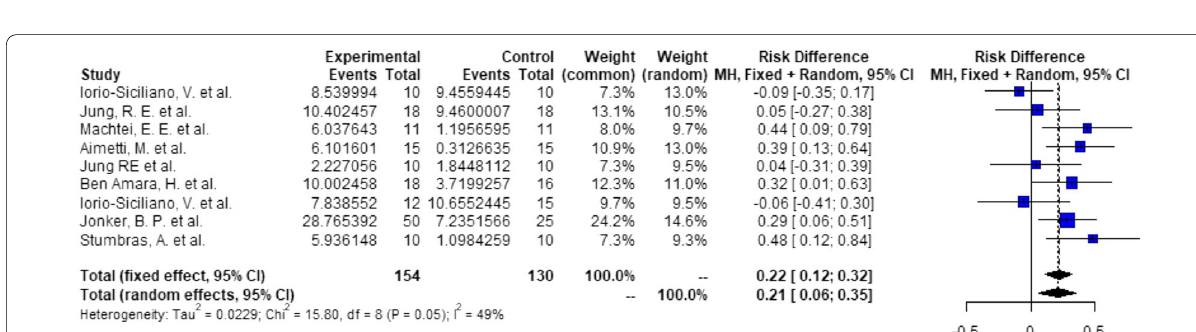
Fig. 8 Meta-analysis results for the binary outcomes for implant placement in a bone envelope of 7.0 mm